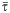
Effect of gait speed (GS) and stride length (SL) modulation on the normalized joint moments τ¯.Joints are organized by row, GS are organized by columns, relative to the subject-specific ss-GS. Conditions corresponding to cued SL values are superimposed on each plot. Lines indicate the group mean, with the shaded region indicating the standard error.